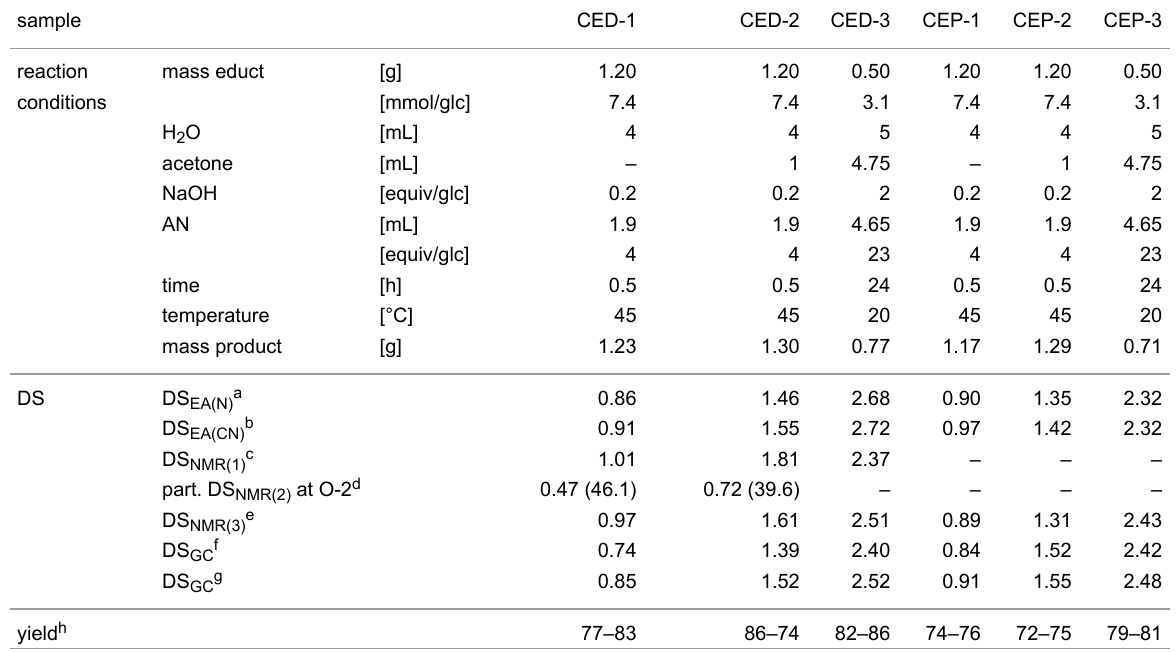
Table 1: Conditions and results of cyanoethylation of dextran (6 kDa) and pullulan (100 kDa) with acrylonitrile (AN) and NaOH. sample